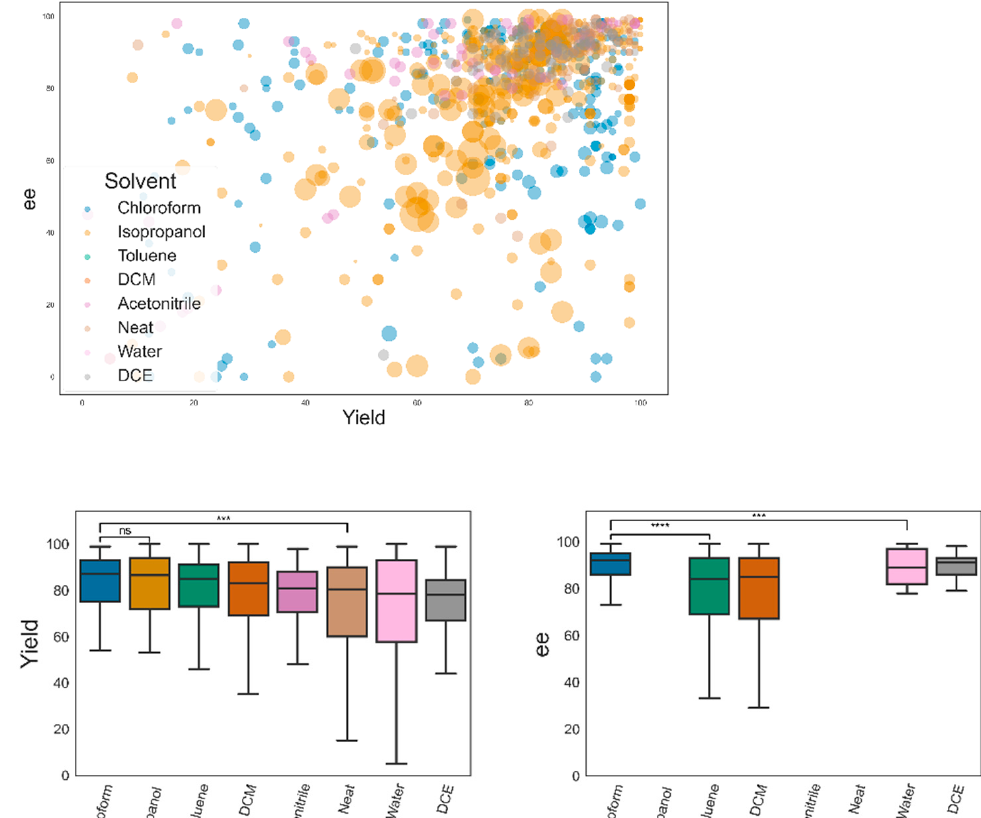
Figure 6. ( upper ) Solvent effects on yield and ee . Catalysts with more than 5 entries, solvents with more than 50 entries, and yields greater than 0 shown ( lower ) yield ( left ) and ee s ( right ) of solvents. Statistical analysis performed using Student’s t -test ( p = 0.97, 0.0006) ( p = 3.92 × 10 − 7 , 0.003). Symbol Meaning: ns p > 0.05, *** p ≤ 0.001, **** p ≤ 0.0001 (For the last two choices only).